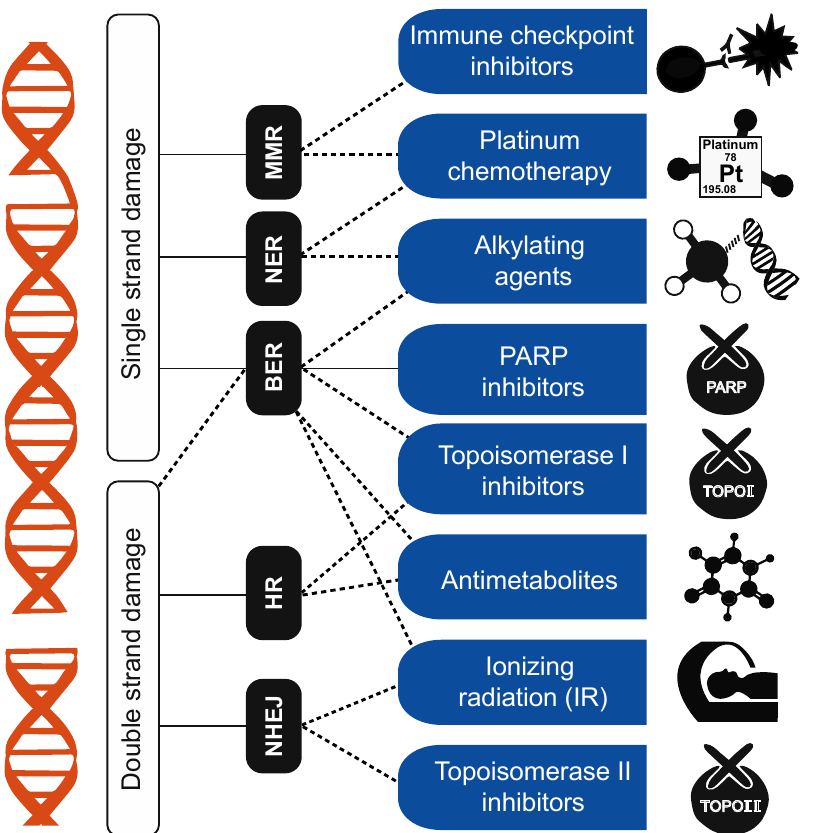
Figure 2. Potential clinical utility of genome-wide DNA-damage signatures: approved cancer drugs that induce DNA damage and associations with specific damage-repair pathways. DNA-damage- inducing drugs (lefthand blue boxes) activate DDR pathways (middle black boxes), directly or indirectly (solid and dashed lines, respectively). DDR pathways repair single- or double-strand damage, and impairment in those pathways leads to whole-genome signatures with potential clinical utility for DNA-damage-inducing